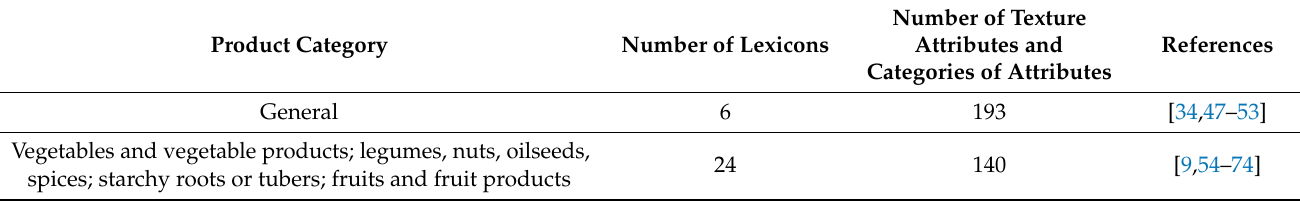
Table 1. Number of lexicons and texture attributes or categories identified in articles and reviews from RL, presented by food